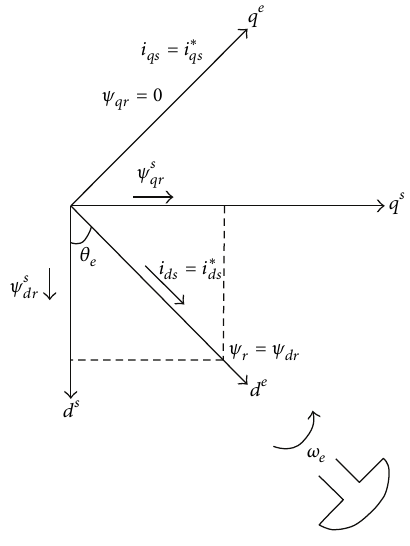
Figure 1: Phasors showing rotor flux